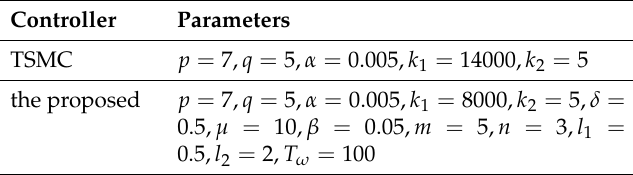
Figure 12. Experimental setup. Table 3. Experimental parameters of different control